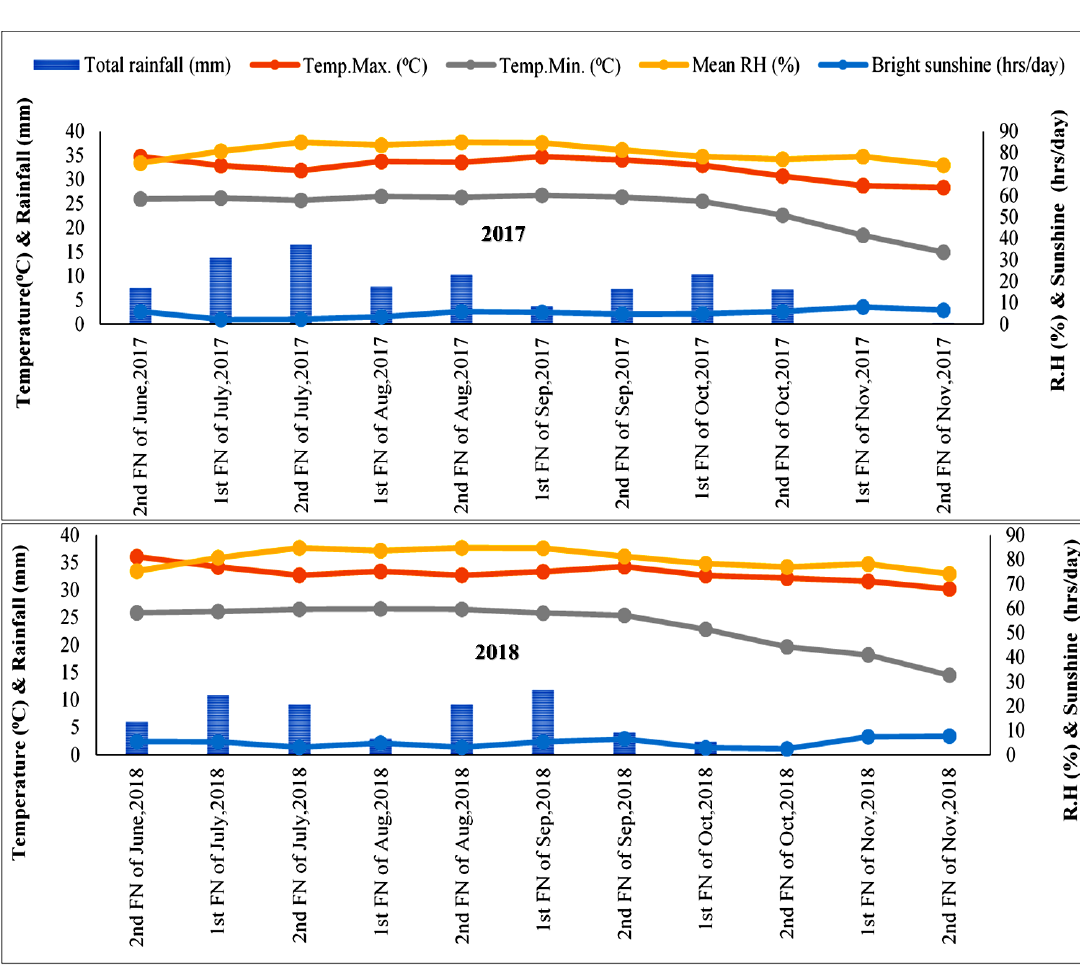
Figure 1. Fortnightly (FN) weather parameters in both crop seasons during 2017 and 2018.